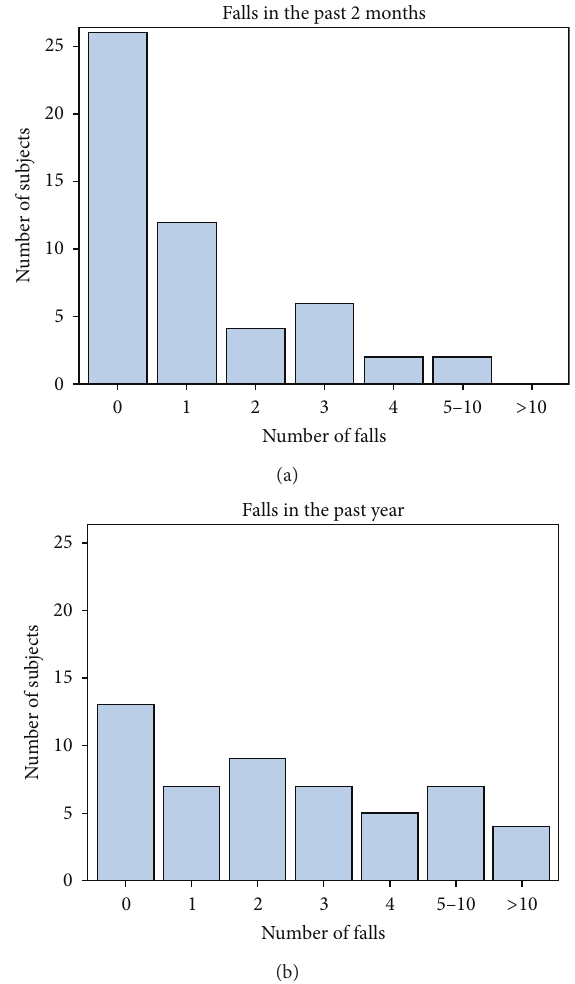
Figure 2: Number of falls sustained over the 2 months and 1 year prior to